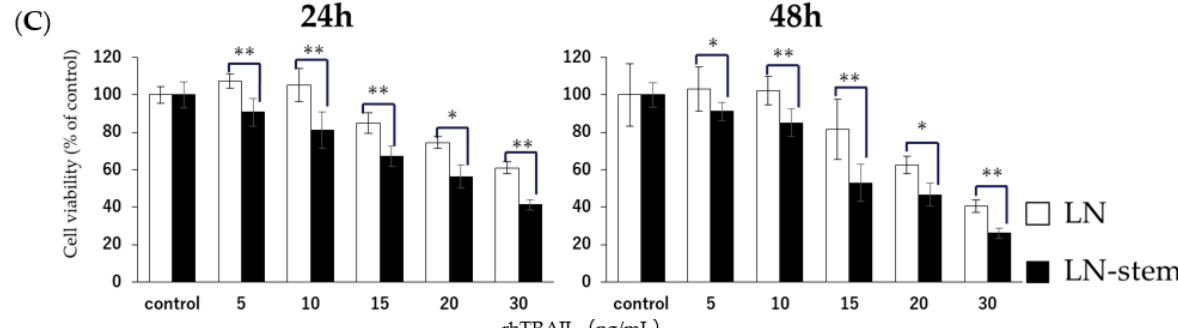
Figure 3. Relationship between TRAIL-DR5 signaling and KHYG-1 cell-induced cytotoxicity against LN-stem cells. ( A ) Comparison of cell-surface expression levels on TRAIL-related receptors (DcR1, DcR2, DR3, DR4, and DR5) between LN-stem cells and LN cells by FACS. Black line, blue line, and red line indicate matched isotype control, LN cells, and LN-stem cells, respectively. Values in the blue and red boxes indicate DR5-positive cell percentages for LN cells and LN-stem cells, respectively. ( B ) mRNA levels of DR5 in LN cells and LN-stem cells. Each column indicates the mean, and vertical lines indicate SEM (n = 3). Values for LN cells are expressed as 1, and values for LN-stem cells are expressed as ratios relative to LN cells. * p < 0.05 when compared with LN cells. ( C ) The effect of rhTRAIL on the viability of LN-stem cells and LN cells when co-cultured for 72 h. Cell viability was determined by the WST-8 assay. Values for the control are expressed as 100%, and values for the other groups are expressed as percentages of the control. Data are the means ± SEM from six samples. * p < 0.05 and ** p < 0.01 when compared with LN cells for each treatment dose.